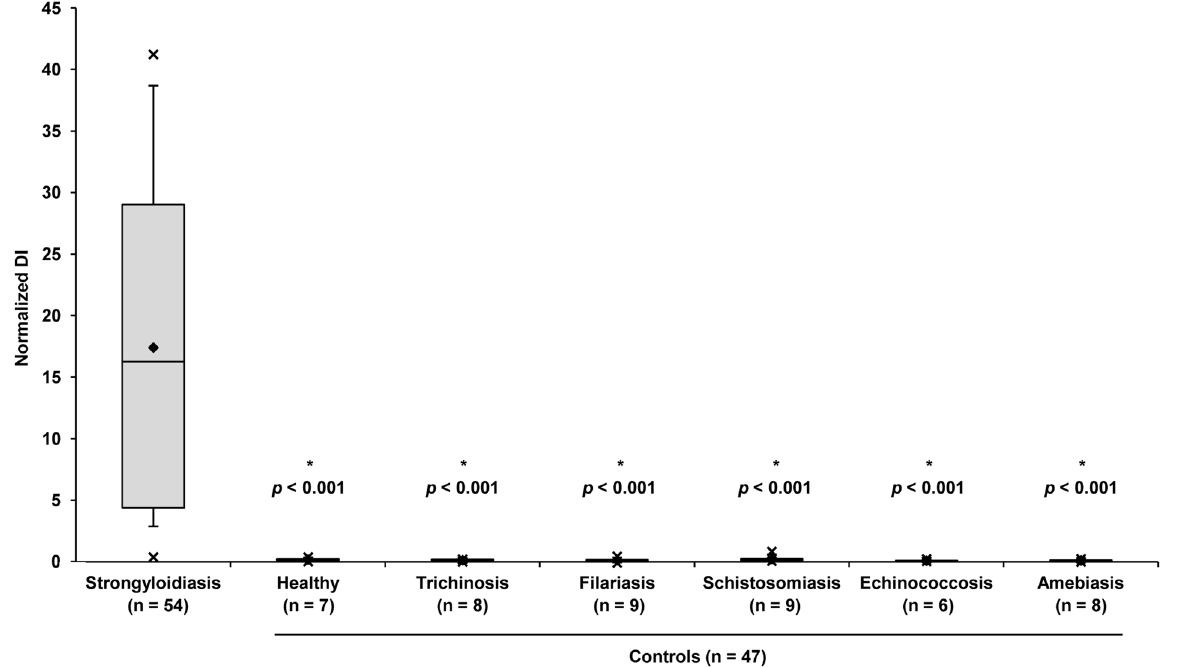
Figure 4. Box and whiskers plot of seven groups of sera tested for anti-NIE IgG antibodies. The plots summarize the results of gold standard Strongyloides samples (n=54) and six control groups comprised of healthy individuals (n=7) as well as those with trichinosis (n=8), filariasis (n=9), schistosomiasis (n=9), echinococcosis (n=6) and amebiasis (n=8). The lower and upper boxes represent the samples in the second and third quartile respectively while the error bars above and below the box correspond to the 95 th and 5 th percentiles. The horizontal lines separating the boxes represent the median and the diamond denotes the mean. X represents the minimum and maximum values. A significant difference was observed between the gold standard Strongyloides and all control groups ( p ,